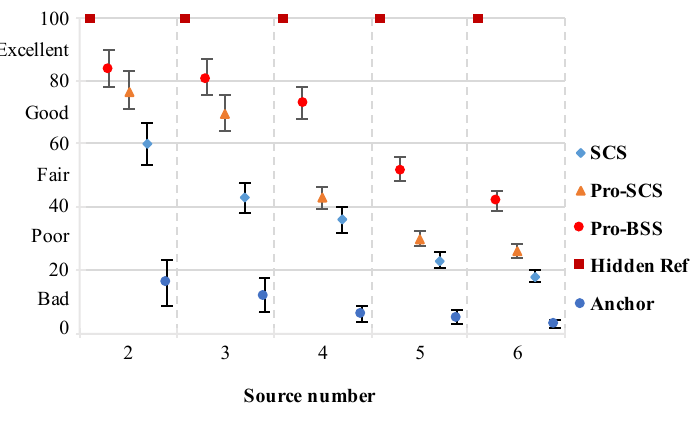
Figure 15. MUSHRA test results of separation = 50 ◦ . Error bars with 95% confidence intervals.